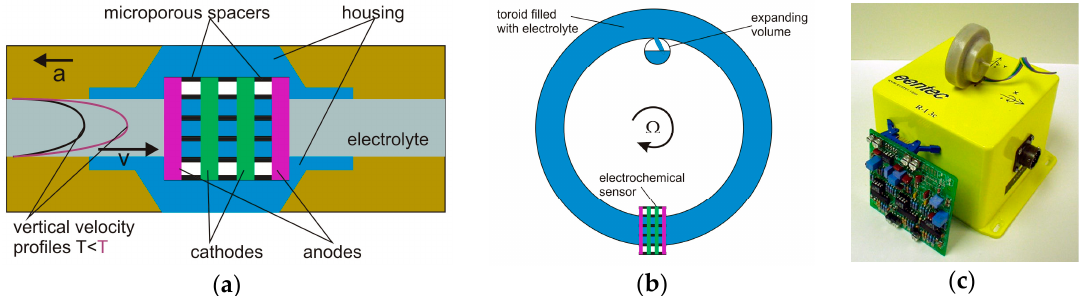
Figure 6. The electrochemical rotational seismometer: ( a ) schematic diagram of the MET transducer [40]; ( b ) a rotational sensor mechanical system design [71]; ( c ) the Eentec R-1 [71].